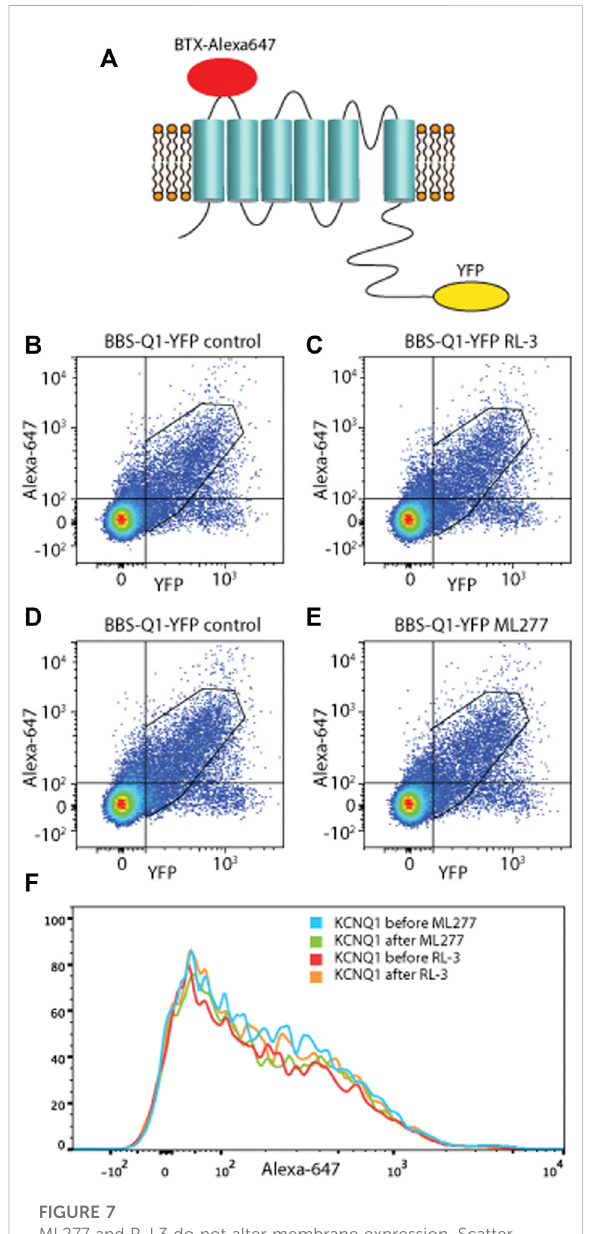
FIGURE 7 ML277 and R-L3 do not alter membrane expression. Scatter plots from Bungarotoxin (BTX 647 ) fl ow cytometry experiments showing the detection of BTX 647 (extracellular marker) and YFP (intracellular tag) where dots in the upper right quadrant represent channels that expressed and traf fi cked to the membrane. (A) Schematic diagram of KCNQ1 with BTX-Alexa 647 andYFP.ForbothRL-3 (B,C) andML277 (D,E) ,therewasnochange in surface expression of channels between control condition (left panels) and after application of drug (right panels). (F) Shows the data as compressed onto the y -axis to further emphasize no signi fi cant